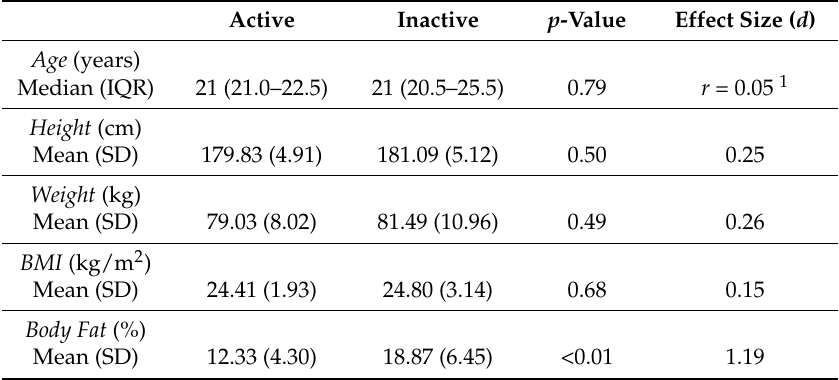
Table 1. Subject characteristics of active ( n = 16) and inactive ( n = 14)